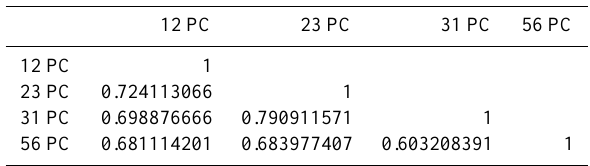
Table 3. Pearson correlation, mass per event by